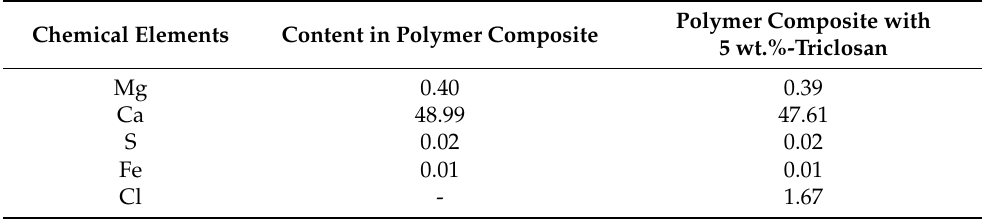
Table 4. Chemical composition of polymer composites (%).